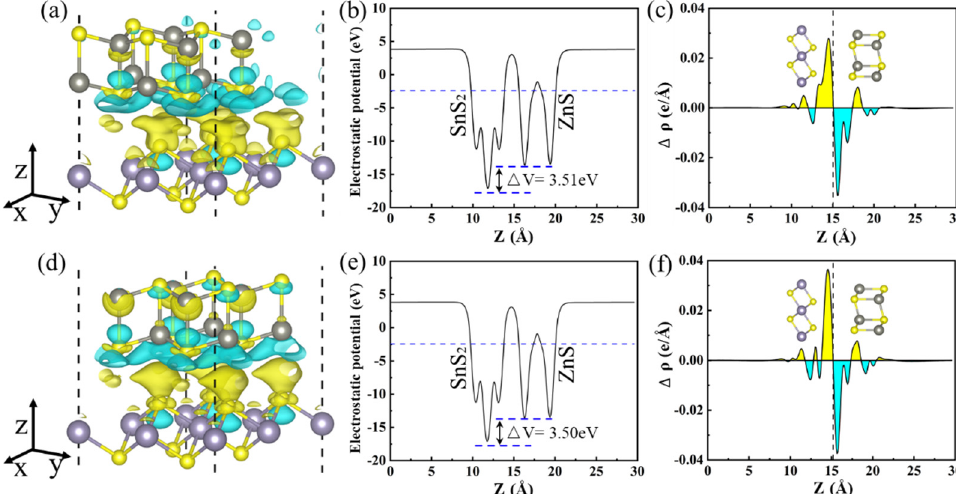
Figure 6. The charge density difference for H3 ( a ) and H4 ( d ) heterojunction and the difference charge density with an isovalue of 0.0001 e Å − 3 . Plane-averaged electrostatic potential drop across the interface of the H3 ( b ) and H4 ( e ) heterojunctions. Planar-averaged electron density difference ∆ ρ (z) for H3 ( c ) and H4 ( f ) heterojunctions. The yellow and cyan areas indicate electron accumulation and depletion, respectively.